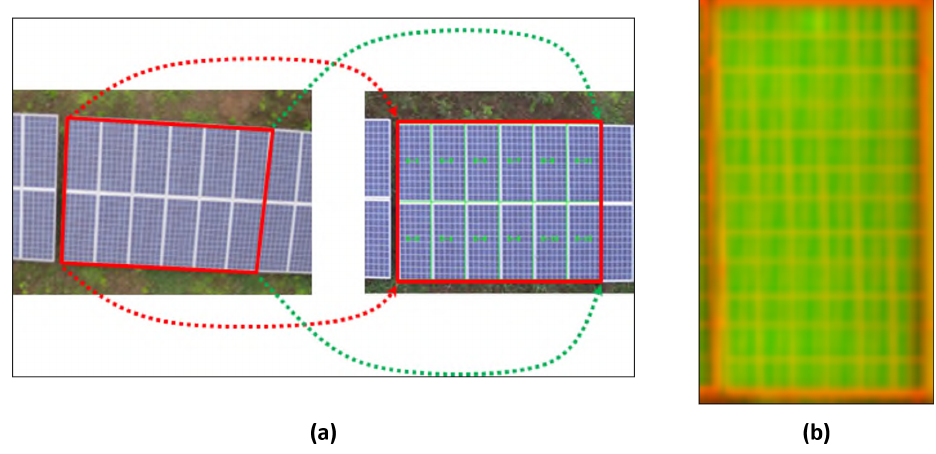
Figure 10. ( a ) Example of image rectification; and ( b ) rxample of extracted individual PV